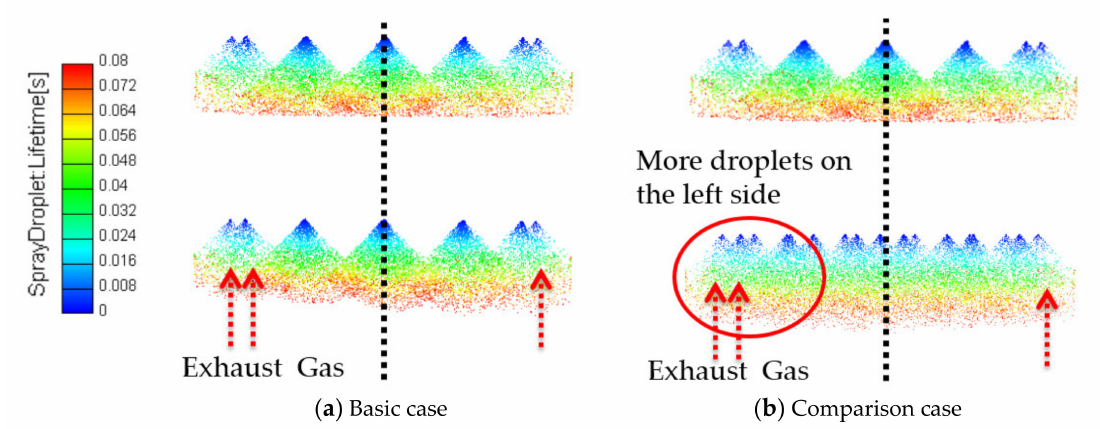
Figure 14. Comparison of the number of droplets that hitting the